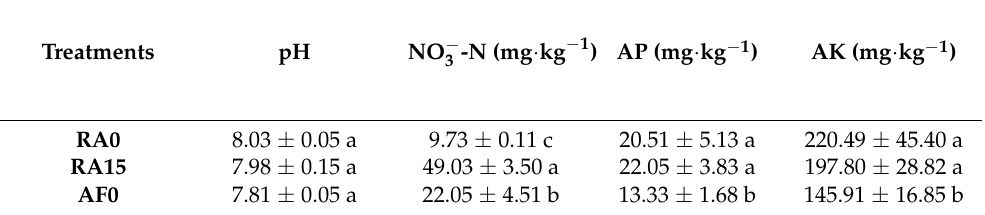
Table 3. Soil properties in different